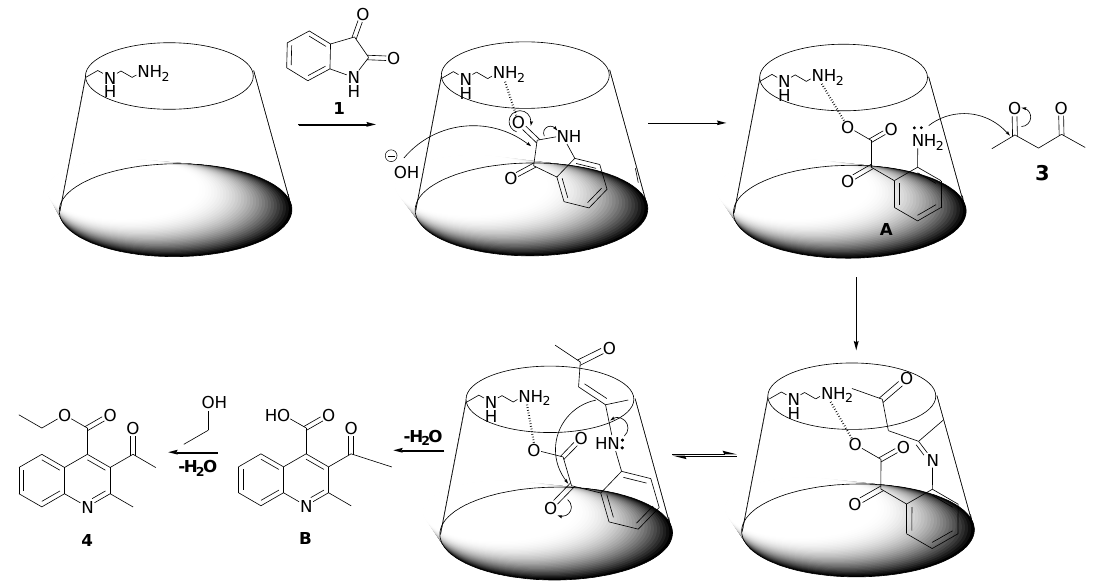
Table S1: The binding constant K c between isatine and AEA– β –CD, spectral data of the compounds, and 1 H NMR and 13 C NMR spectra of all